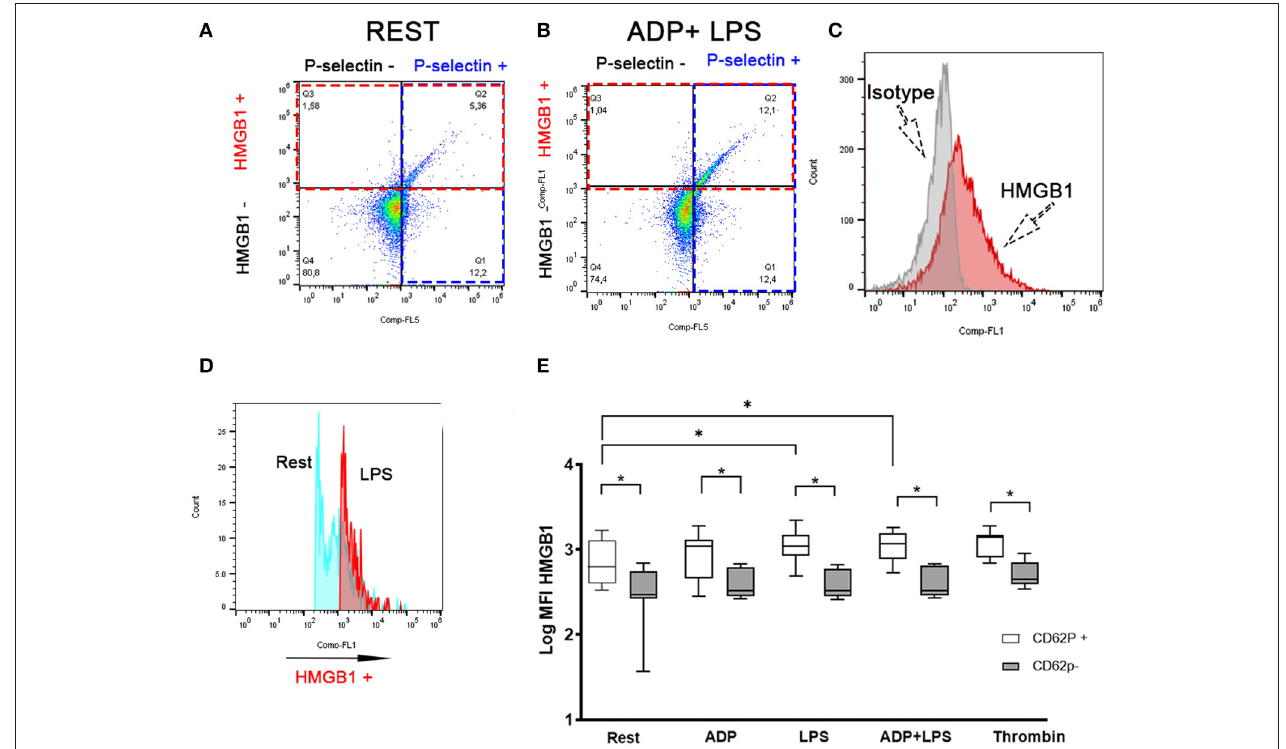
FIGURE 3 | LPS-mediated HMGB1 upregulation occurs in activated platelets. Representative scatter dot plots in unstimulated (rest) (A) and platelets treated with 10 µ M ADP and 5 µ g/ml LPS (B) illustrating that canine platelets express HMGB1 mostly in P-selectin positive (intersection between red and blue box) platelets. (B) LPS in the presence of ADP leads to an increased number of cells co-expressing HMGB1 and P-selectin (Intersection between red and blue boxes). (C) Representative histograms demonstrating isotype control and HMGB1-positive platelets. (D) Representative histograms demonstrating the upregulation of surface HMGB1 between unstimulated resting (blue) and LPS-treated (pink) platelets. (E) Box and whisker box plots of surface HMGB1 expression, measured as median fluorescence intensity (MFI) (on a log 10 scale) by flow cytometry in eight dogs. Activated platelets shown here as P-selectin (CD62P) positive platelets expressed significantly more HMGB1 than CD62P negative platelets. Only CD62P positive platelets showed an increase response to LPS in the absence or presence of ADP. Each line represents the median while the box represents the 25th and 75th percentile. Whiskers represent the range. Paired t -test was used to compare HMGB1 expression between CD62P positive and negative platelets in each treatment while one-way ANOVA of repeated measures was used to assess treatment-effect on HMGB1 expression for either CD62P positive or CD62P negative platelets. This is then followed by post-hoc analyses by Tukey’s test. * p < 0.05.